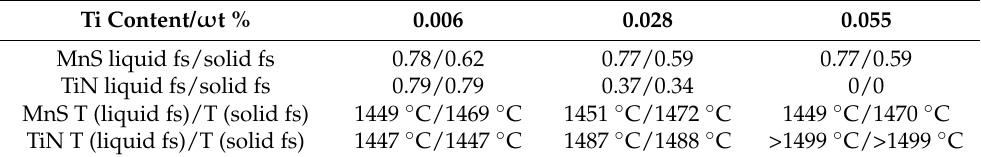
Table 5. Initial solid phase ratio and initial precipitation temperature of MnS and TiN in solid–liquid two-phase